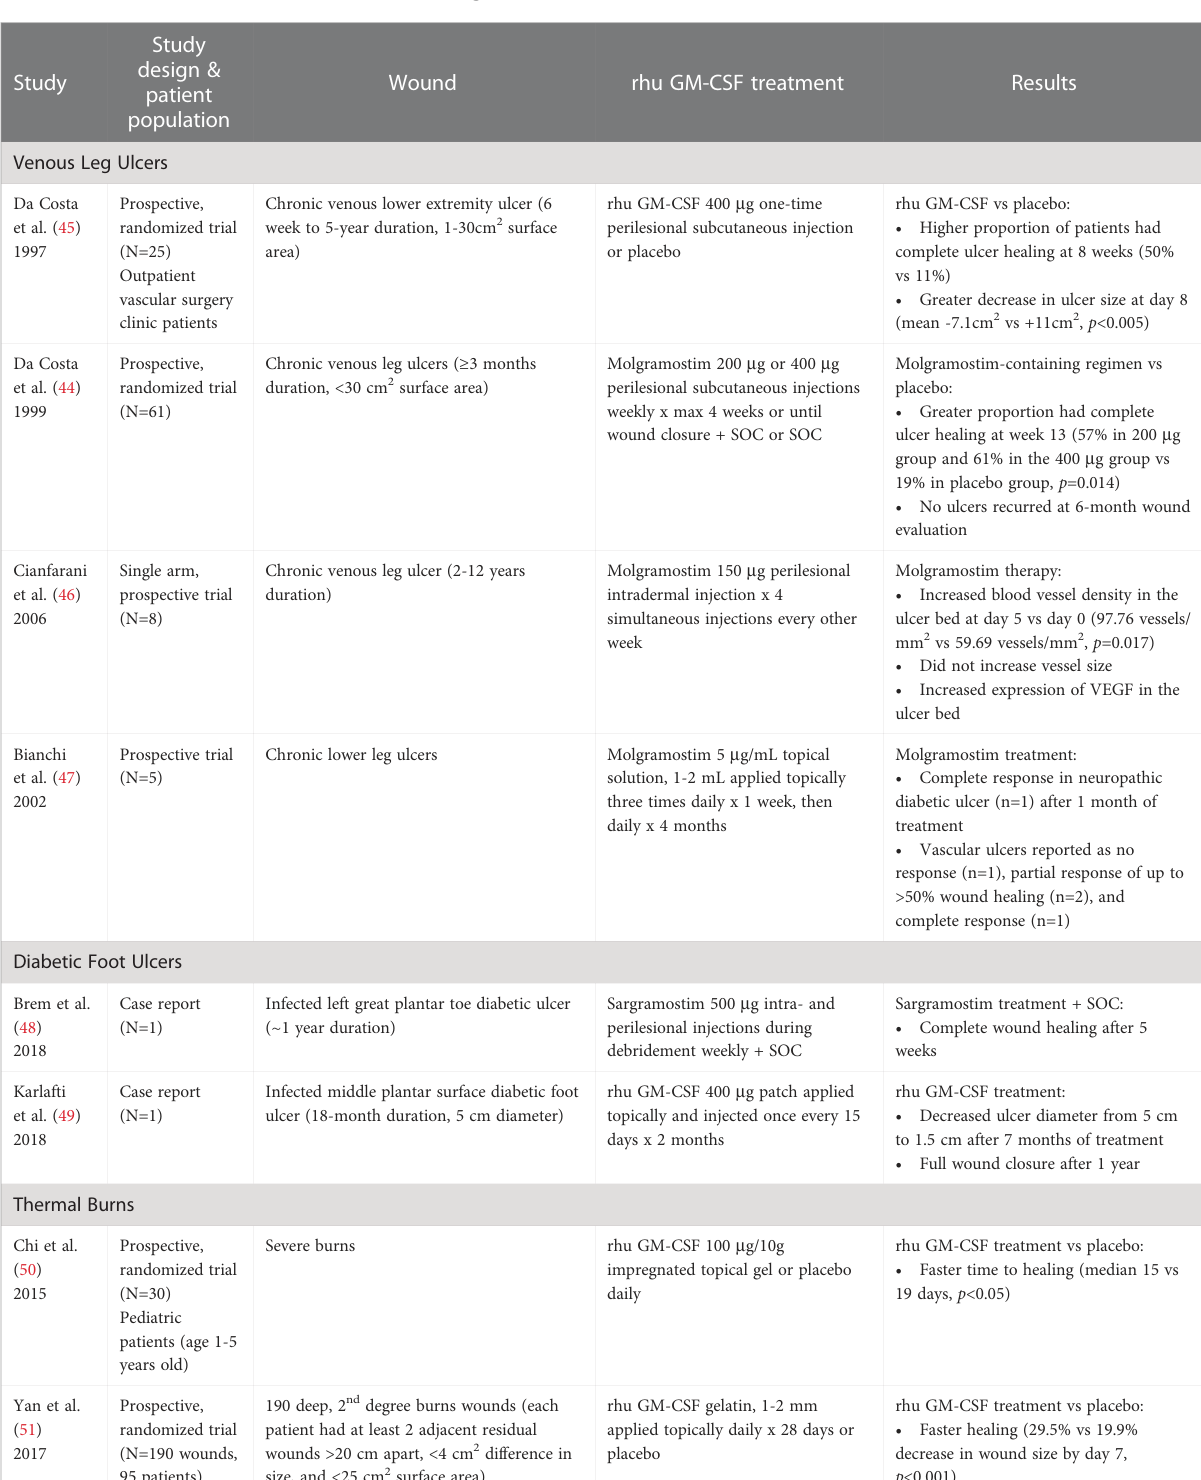
TABLE 4 Clinical studies of rhu GM-CSF in wound